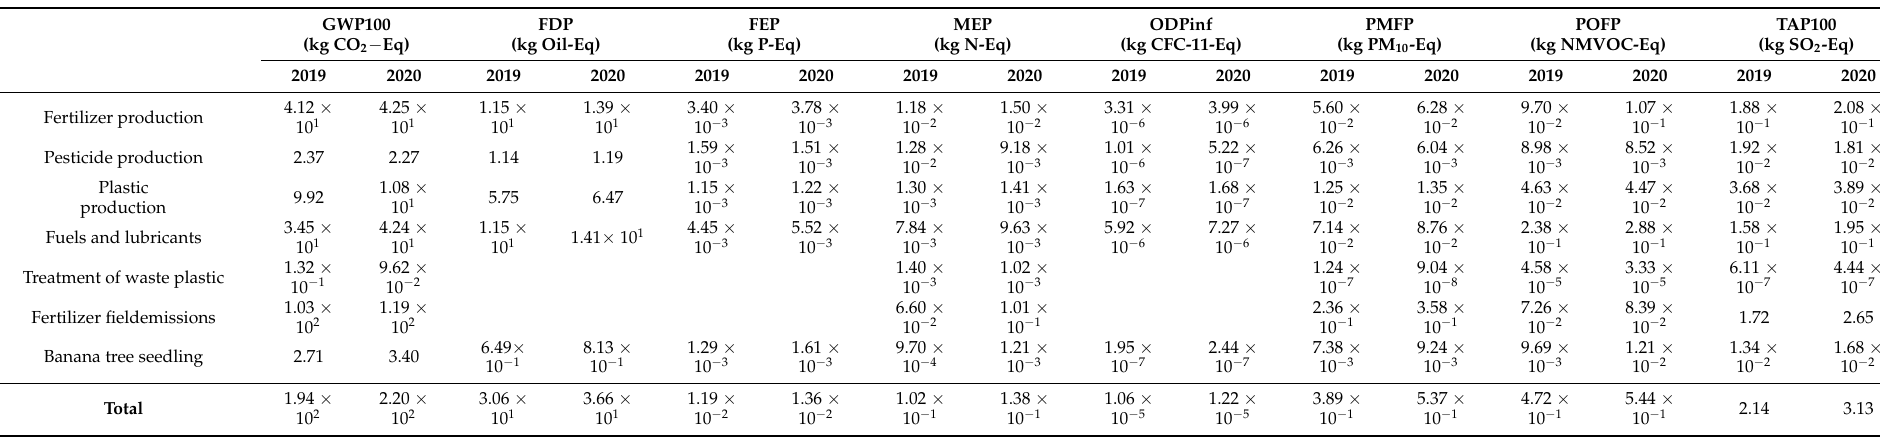
Table 3. Impact category indicator results for 1 ton of “Banana at-the-farm-gate” for years 2019 and